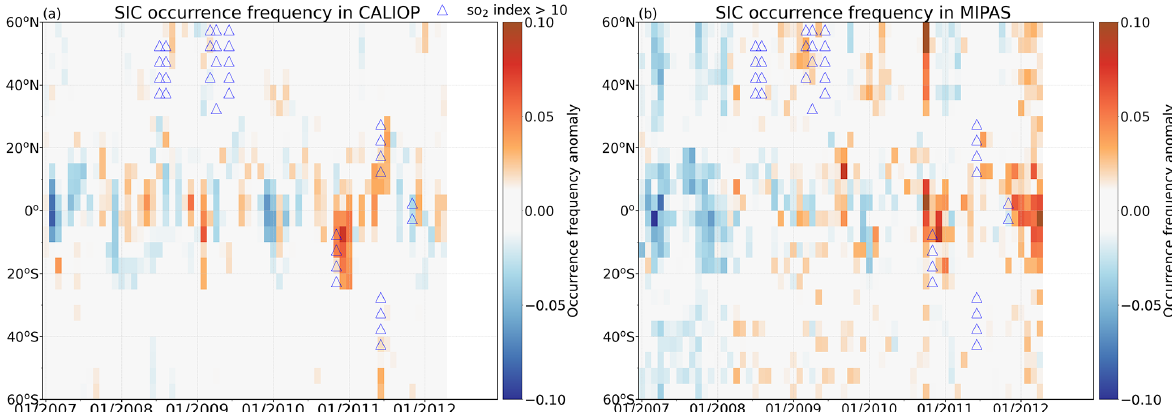
Figure 12. Monthly anomalies of SIC occurrence frequencies from CALIOP (a) and MIPAS (b) measurements. Blue triangles are data with SI > 10K, as derived from AIRS